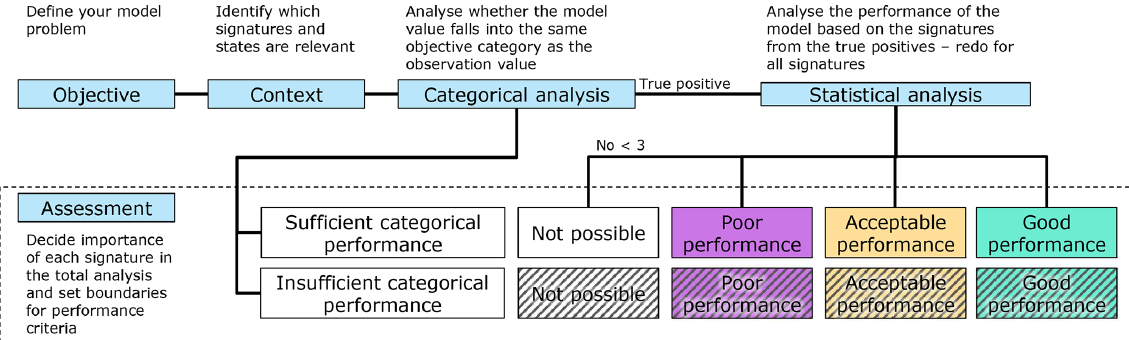
Figure 1. Identified steps (blue boxes) for assessing model performance. With respect to accommodating colour-blindness, the yellow and red colours are changed to orange and purple.